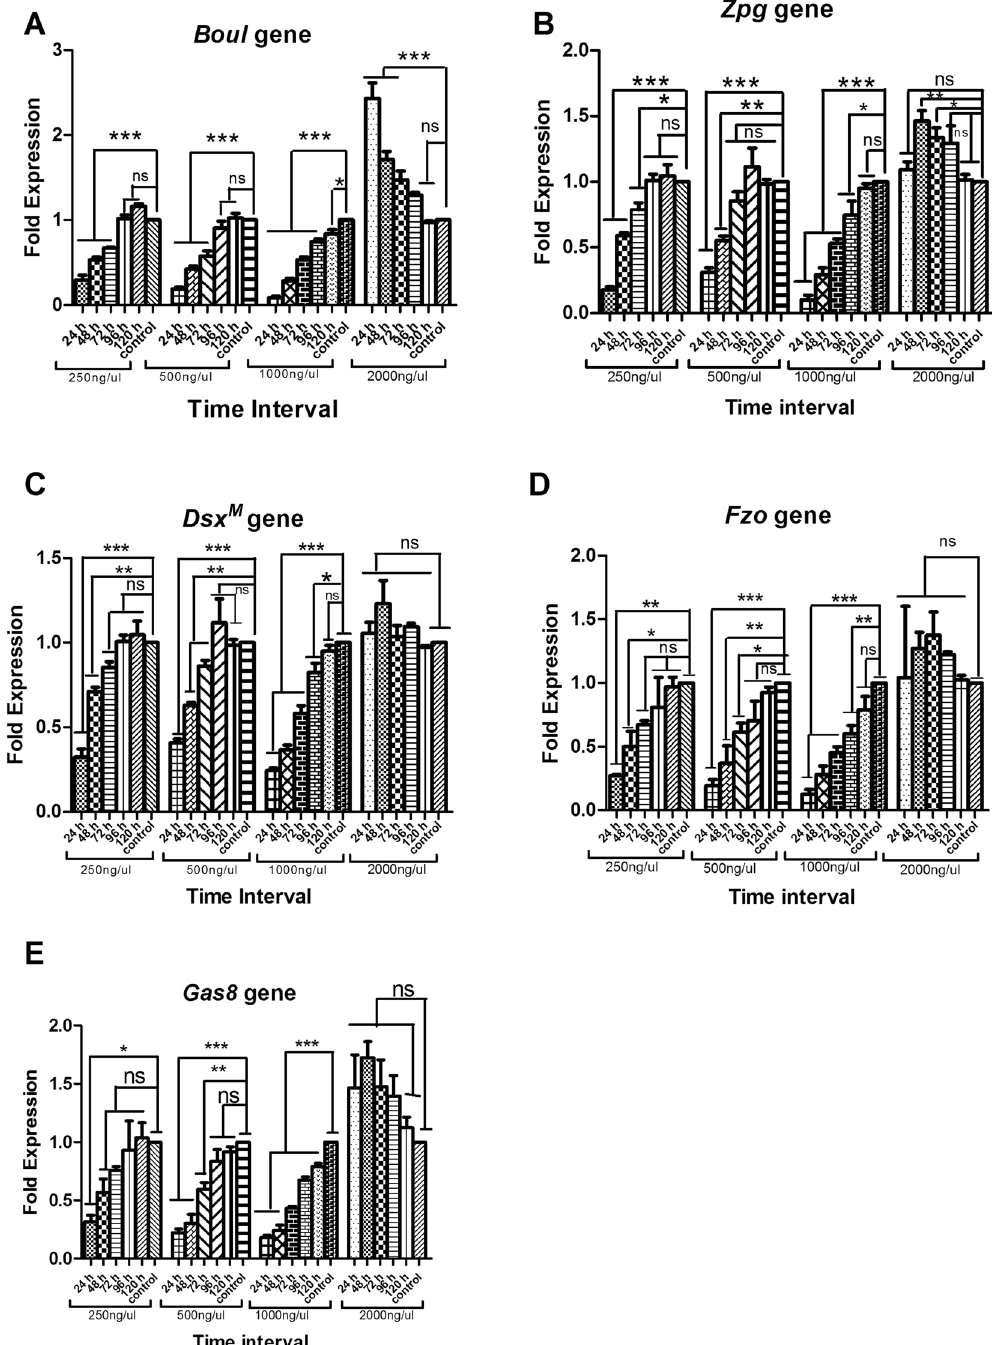
Figure 2. Effects of RNAi silencing of target genes on five consecutive days at different concentrations. Effect of orally administered dsRNAs against target genes ( boul , zpg , dsx M , fzo and gas8 ) ( A – E ) at different concentrations (250, 500, 1000 & 2000 ng/ul) were analyzed. Normalized target gene expression is reported relative to the expression of the ds-EGFP control, which was set to 1-fold. All error bars depict the SE of the mean of three independent replicates. Treatments were compared with their respective controls using ANOVA (Dunnett-test, P < 0.05). * , ** , *** and ns indicates P < 0.05, P < 0.01, P < 0.001 and non-significant,